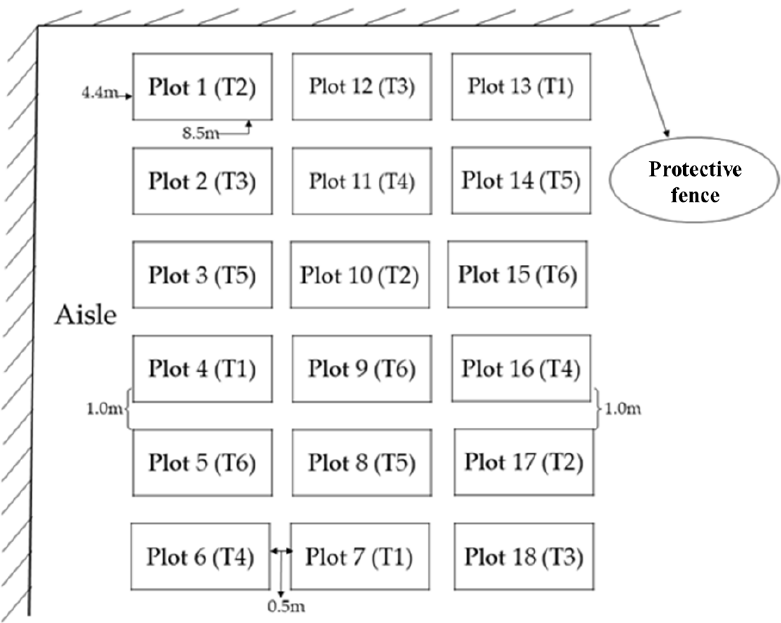
Figure 1. The layout of the experimental blocks.